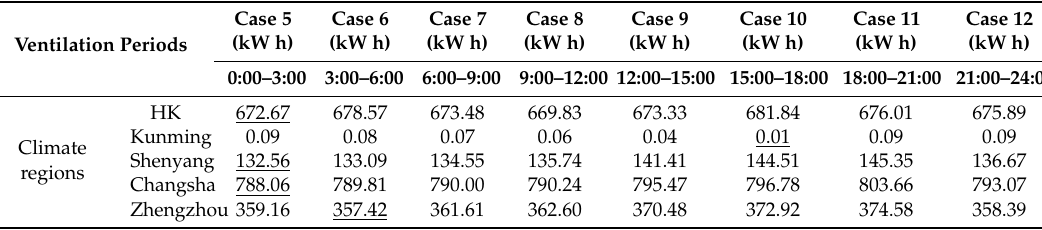
Table 8. Summer cooling energy consumption of building models with PCM in different ventilation